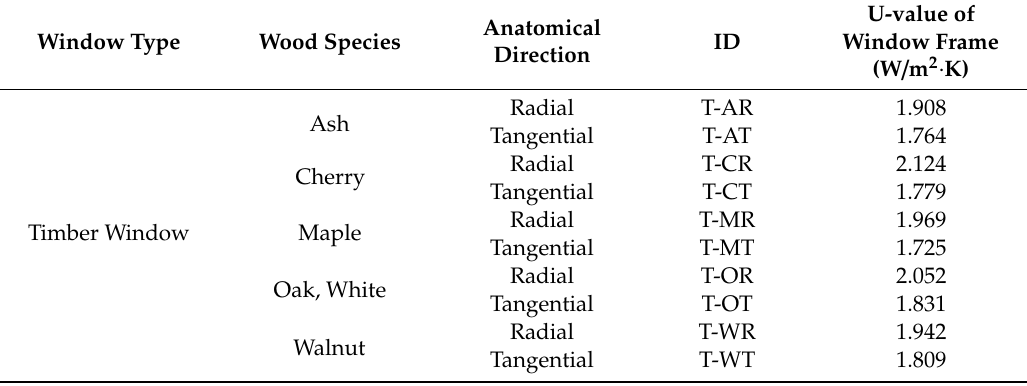
Table 4. Summary of window type categories for the analysis with resulting